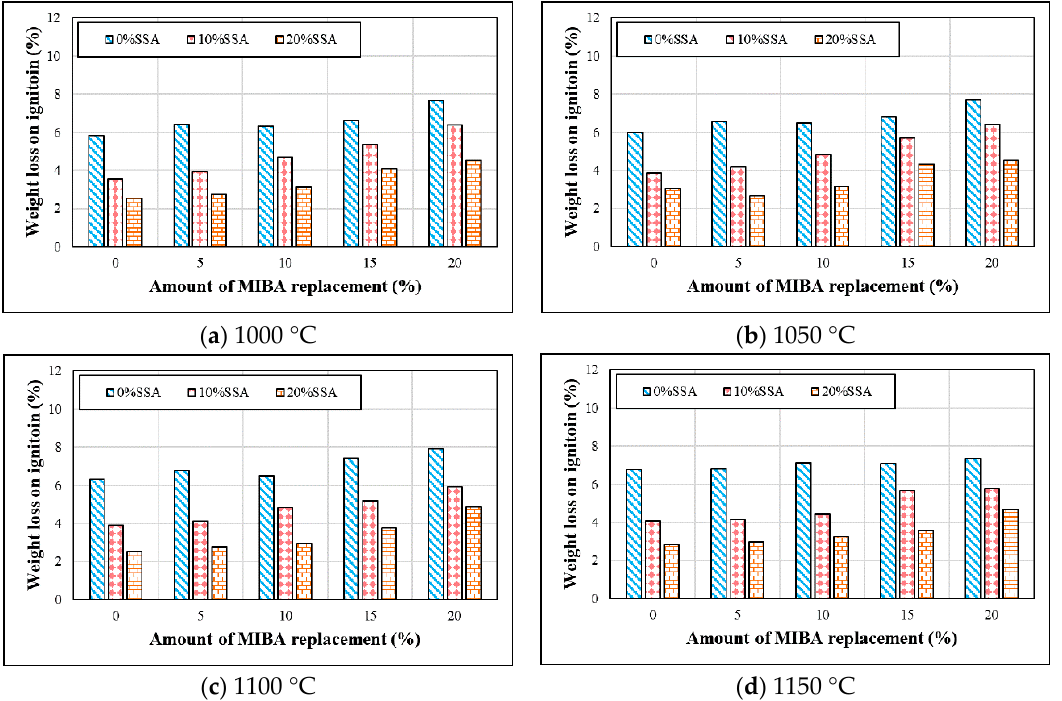
Materials 2021 , 14 , x FOR PEER REVIEW Figure 5. Weight loss ignition at different sintering temperature. ( a ) 1000 °C; ( b ) 1050 °C; ( c ) 1100 °C; ( d ) 1150 °C. Figure 5. Weight loss ignition at different sintering temperature. ( a ) 1000 ◦ C; ( b ) 1050 ◦ C; ( c ) 1100 ◦ C; ( d ) 1150 ◦ C.